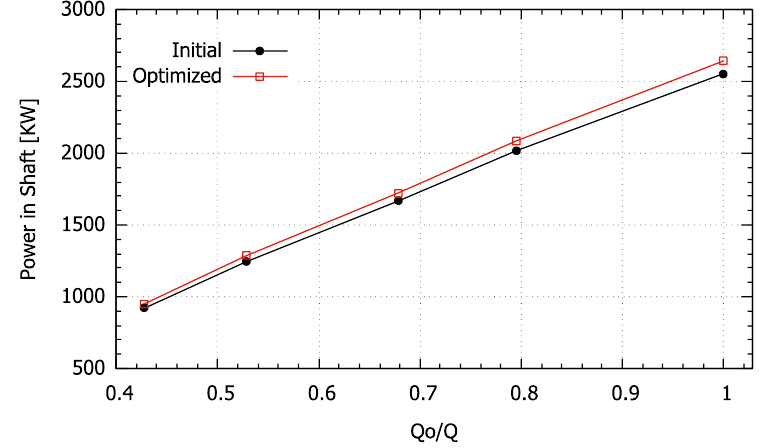
Figure 17. Optimized Bucket